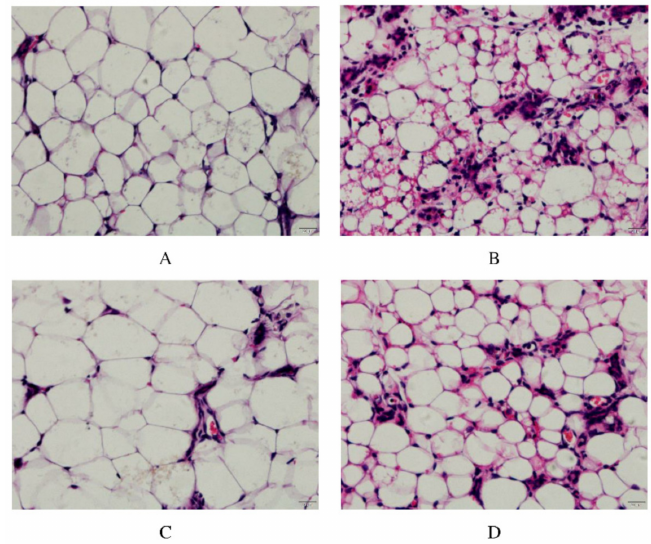
Figure 2. ALE alleviated pathological damage of the LPS-stimulated mammary gland in mice. Note: ( A ): Control group, ( B ): LPS group, ( C ): ALE group, ( D ): LPS + ALE group.